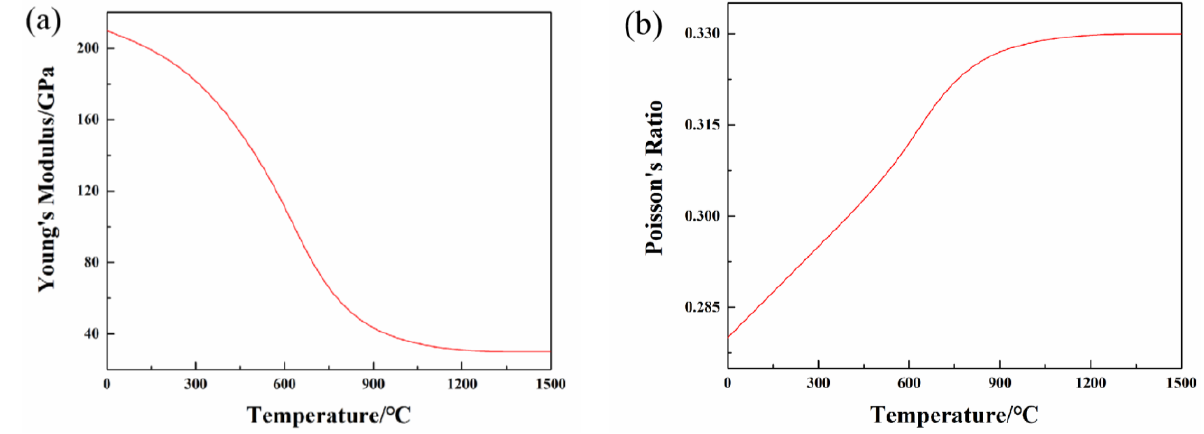
Figure 7. Elasticity of DP600 ( a ) Young’s modulus, ( b ) Poisson’s ratio [28].